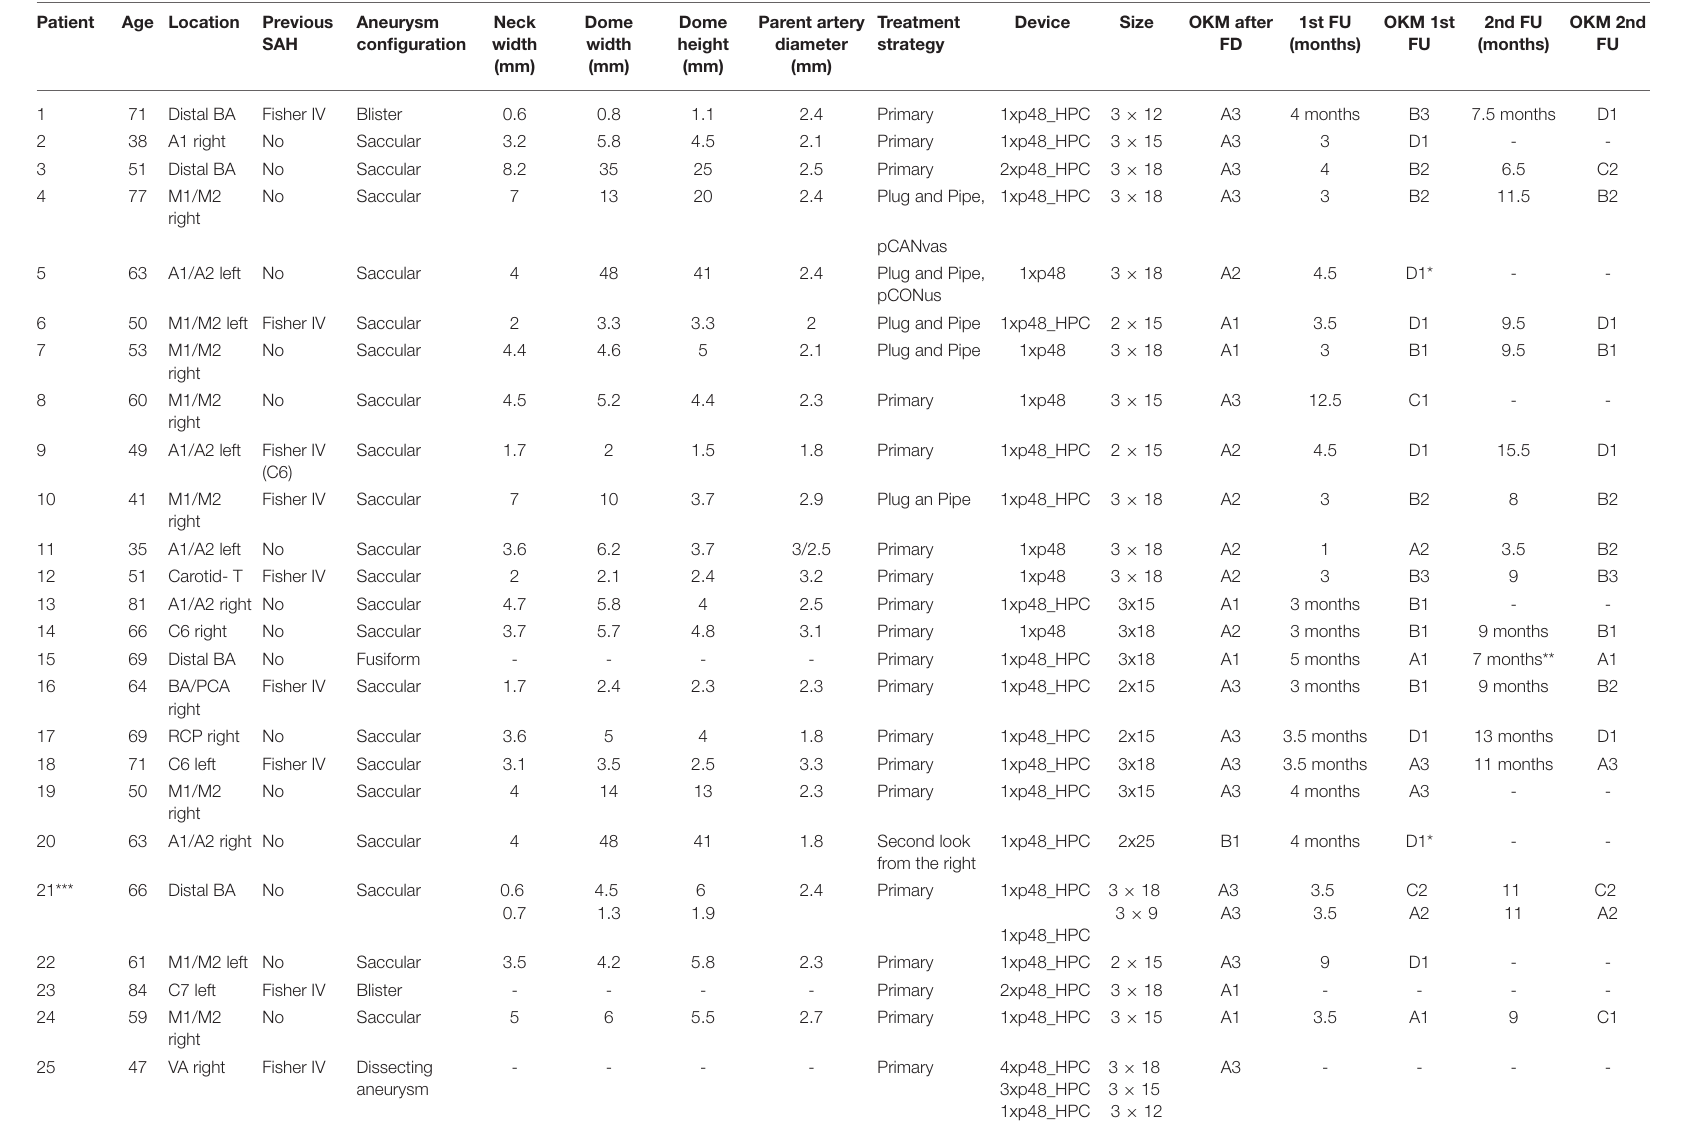
TABLE 1 | Relevant information of all included